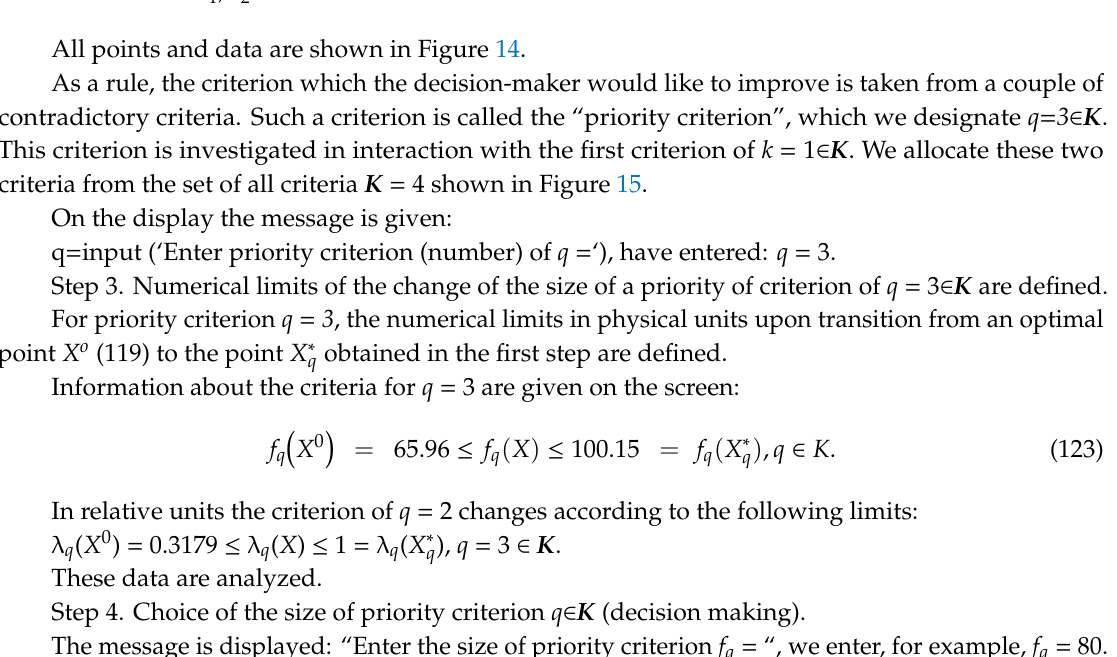
Figure 15. The solution of the λ -problem (first and third criteria) in a three-dimensional system of coordinates of x 1 , x 2 and λ .